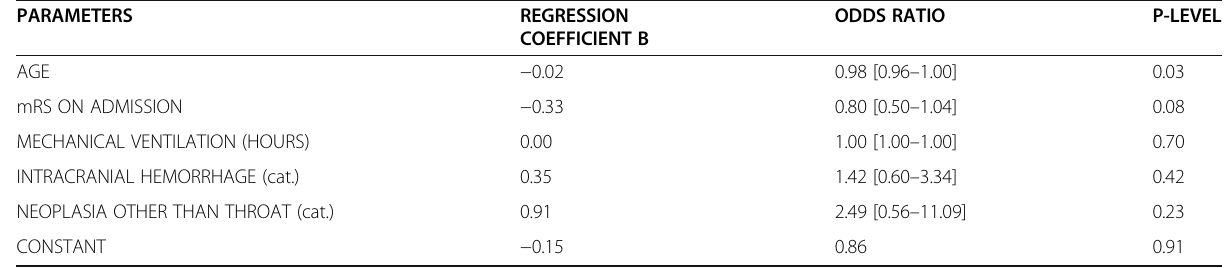
Table 3 Logistic regression analysis for early decannulation (within 24 h from first FEES after end of mechanical ventilation) mRS = modified Rankin Scale, cat = categorical; Nagelkerke R 2 : 0.047